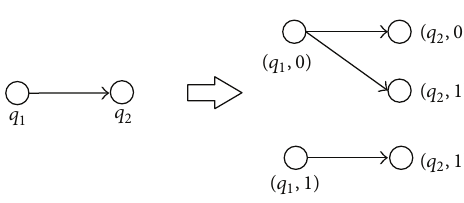
Figure 1: Fair edges to fair states. Figure 2: Assertion graph to finite-state